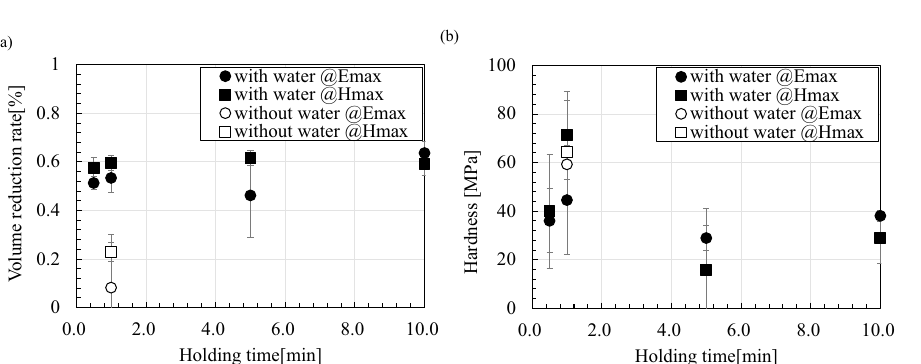
Figure 6. Retention time dependence of the ( a ) volume reduction rate and ( b ) rigidity of the mixture sintered at 1000